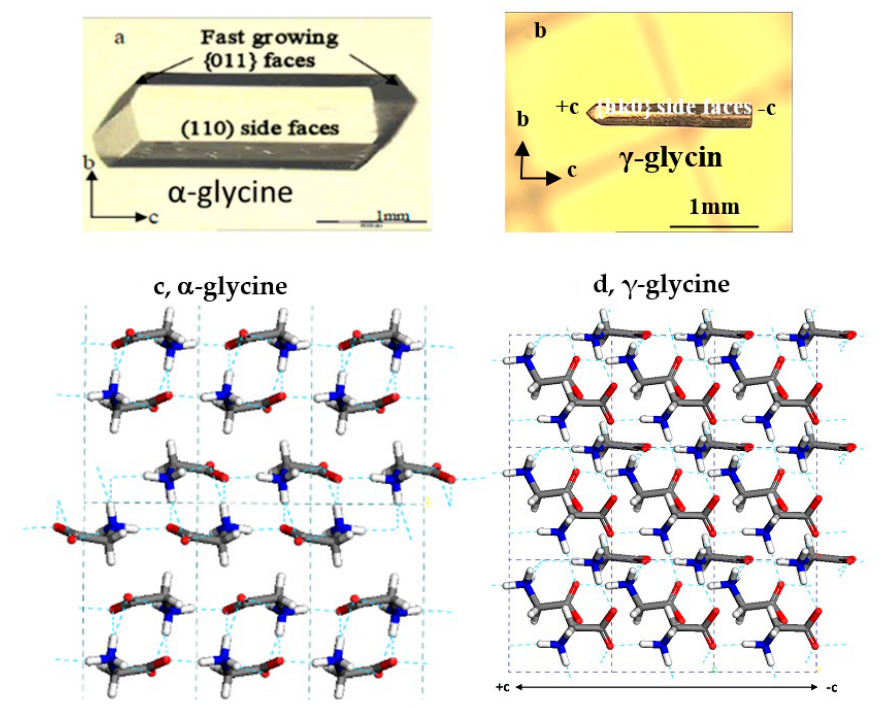
Figure 1. Typical habits ( a,b ) and different crystalline structures ( c,d ) (built using Materials Studio) of α -glycine and γ -glycine. Atom color scale in solid packing: C, dark gray; H, white; O, red; N,